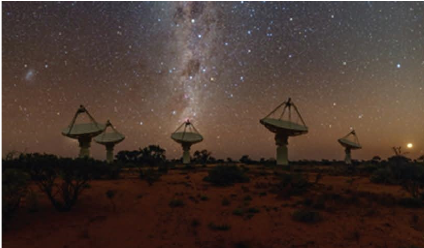
Figure 12: Australian square kilometer array pathfnder (https:// www.csiro.au/en/news/News-releases/2021/In-the-blink-of-an- eye-astronomers-win-prestigious-American-science-prize).